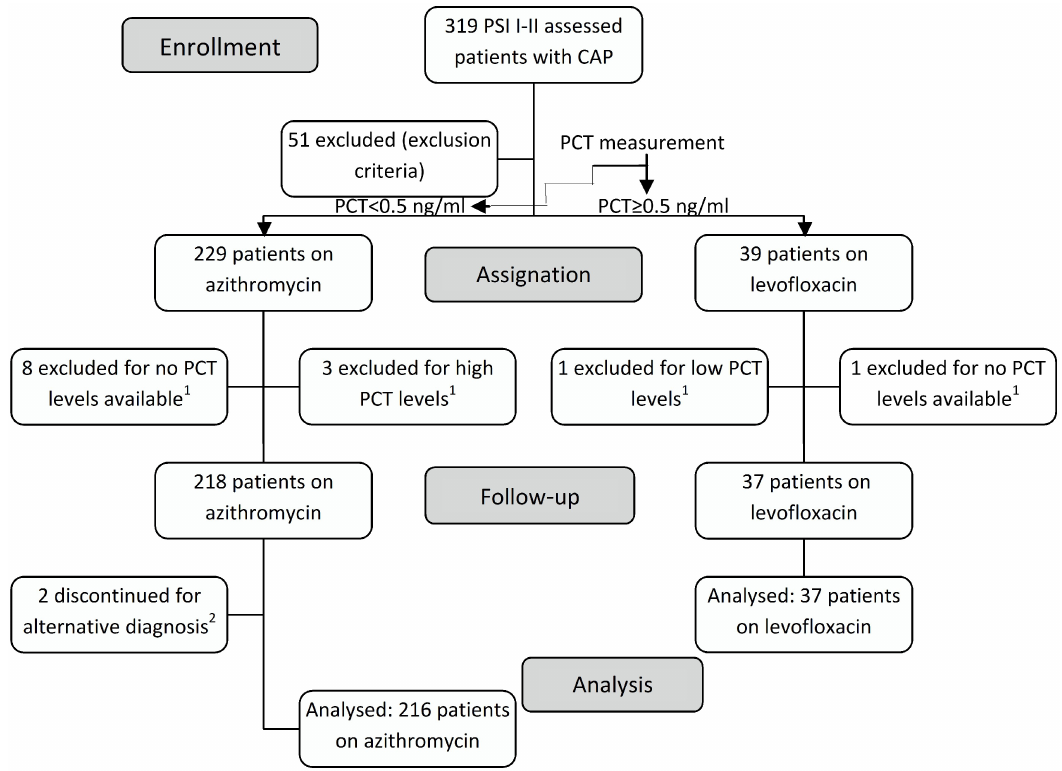
Fig 1. Flowchart of patients with CAP. PSI I-II indicate Pneumonia Severity Index risk classes I and II; CAP, community- acquiredpneumonia; PCT, procalcitonin. 1 Those cases were protocol violations, and were excludedfrom the study. 2 One patient was diagnosed with pulmonarytuberculosis; another patient was diagnosed with